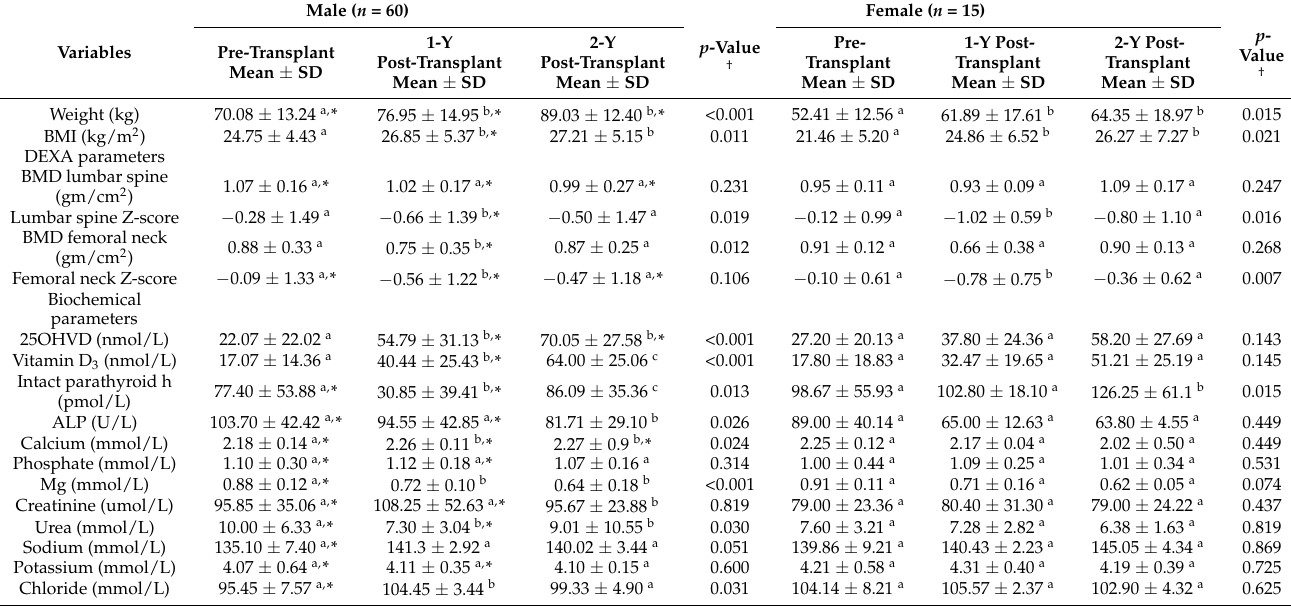
† p -values of the three related samples by Friedman’s two-way analysis of variance by ranks. Values with different superscripts ( a and b ) mean significant vs. pretransplant phase; * Significant versus the related samples in the women group by Mann–Whitney U test; BMI is body mass index; DEXA is dual-energy X-ray absorptiometry; BMD is bone mineral density; 25OHVD is 25 hydroxyvitamin D; ALP is alkaline phosphatase enzyme; Mg is magnesium.